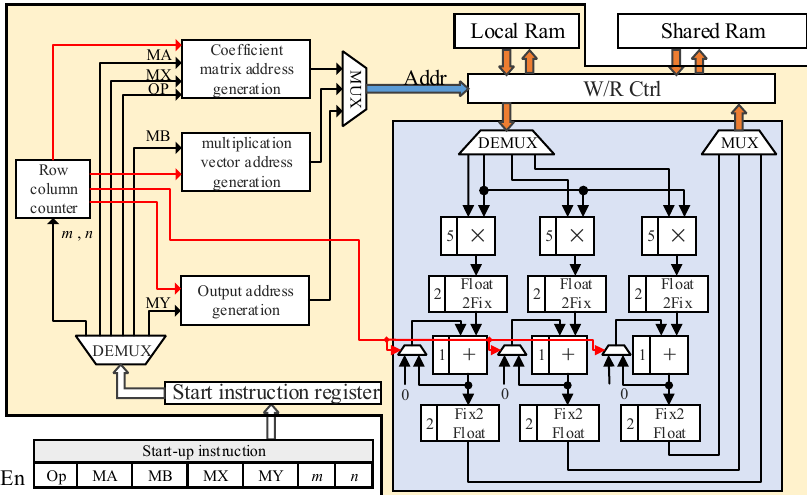
Figure 7. Algorithm modularization architecture.